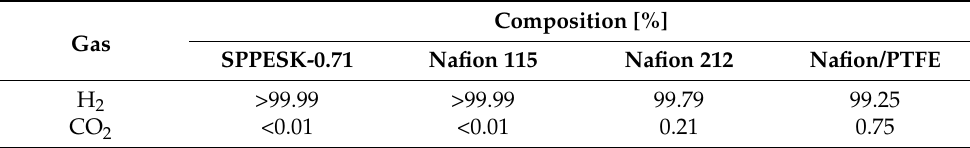
Table 5. Hydrogen purity of the product gas (inlet stream properties: 56.7 mA · cm − 2 , 40 ◦ C, 1 atm, 75 vol.% CO 2 )